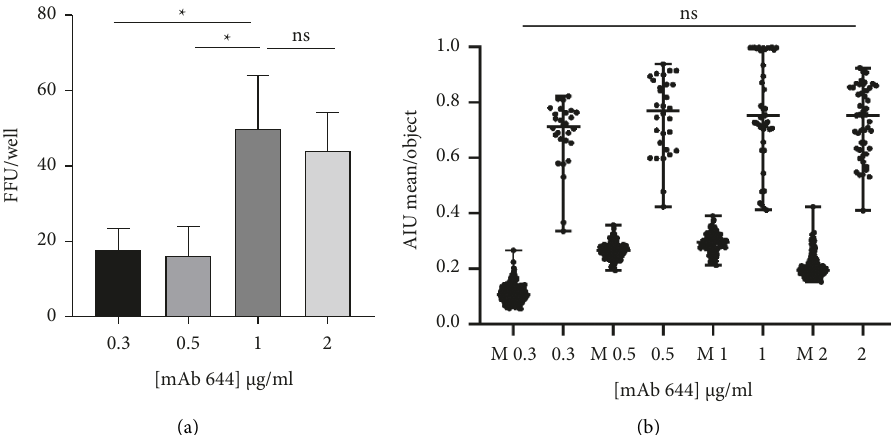
Figure 2: Selection of the optimal concentration of the mAb for carrying out the ZIKV FFA. The FFA was performed at 24hpi, and different concentrations of mAb 644 anti-NS1 ZIKV were used as the primary antibody. (a) Mean ± standard deviation of the number of FFUs/well counted at the 10 − 3 dilution for each antibody concentration. ∗ p < 0 . 05, Tukey’s posttest for multiple comparisons. (b) Median ± range of the average AIU per FFU measured for each antibody concentration with the CellProfiler ™ free software. ∗ p < 0 . 05, Dunn’s posttest. M: